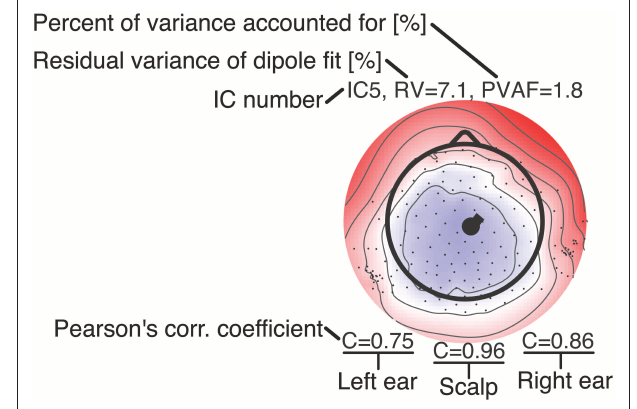
FIGURE 7 | Legend for the component maps shown in Figure 8